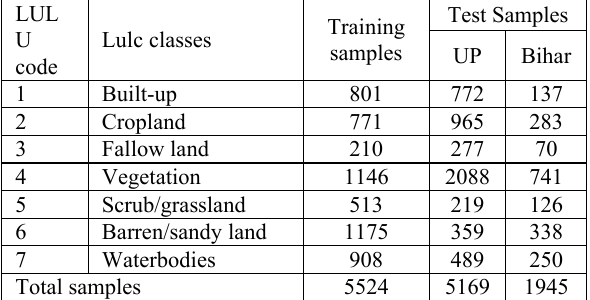
Table 3. Training and test samples used